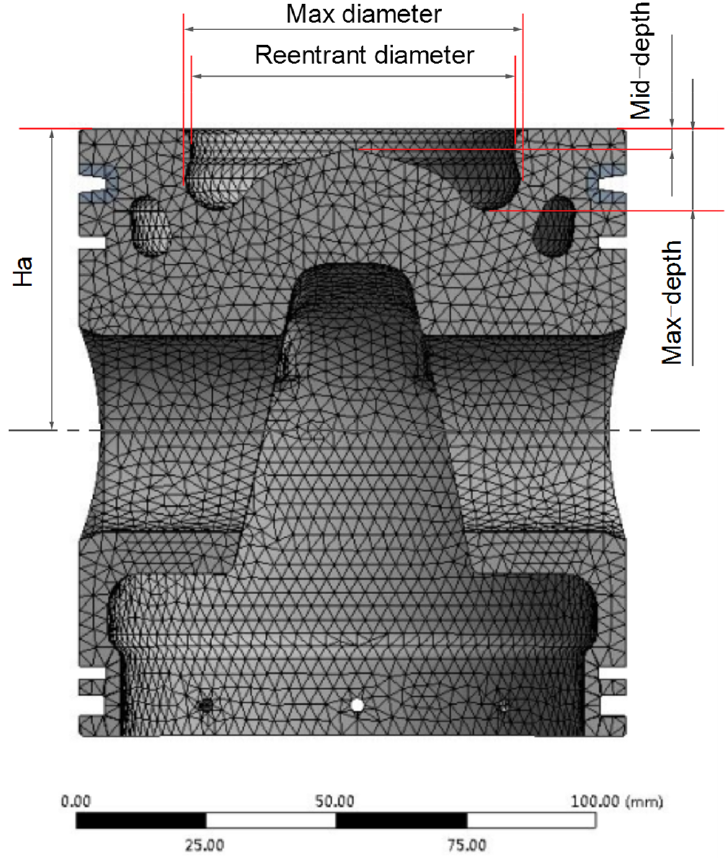
Figure 2. FE model.